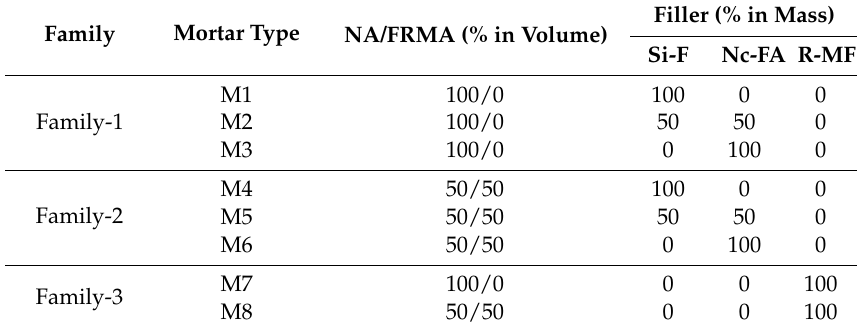
Table 1. Experimental design: nomenclature. Si-F, siliceous filler; Nc-FA, non-conforming fly